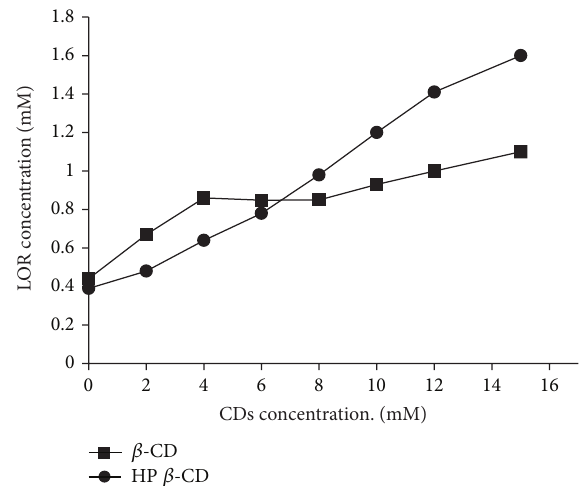
Figure 1: Effect of 𝛽 -CD and HP 𝛽 -CD concentrations on LOR solubility (in aqueous phosphate buffer, pH